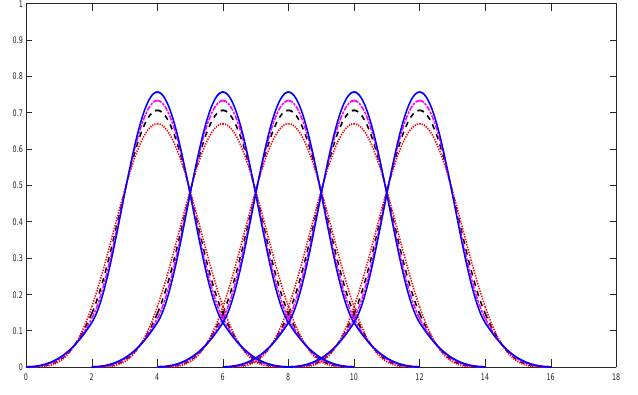
Figure 3. Effect of SP. Table 1. Different values of shape parameter λ